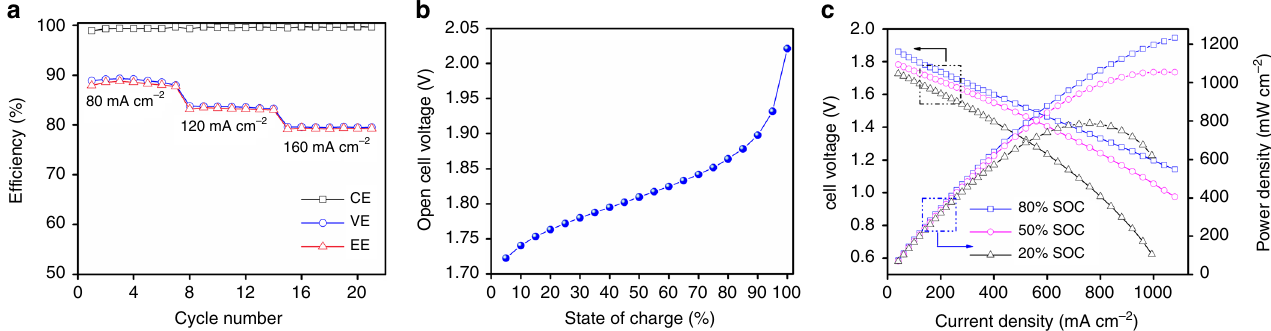
Fig. 7 Battery performance of the alkaline zinc – iron fl ow battery. a The cycling performance of the alkaline zinc – iron fl ow battery employing a P20 membrane at different current densities. b The open-cell voltage versus state-of-charge of an alkaline zinc – iron fl ow battery using a P20 membrane. The above test was conducted in a battery with an active area of 48 cm 2 . c The polarization of the alkaline zinc – iron fl ow battery at 80% SOC, 50% SOC, and 20% SOC using a P20 membrane. The polarization of the alkaline zinc – iron fl ow battery was investigated using a battery with active area of 9 cm 2 . SOC state-of-charge; P20 is a negatively charged nanoporous membrane, where the sulfonated poly(ether ether ketone) (SPEEK) content in the polymer is 20